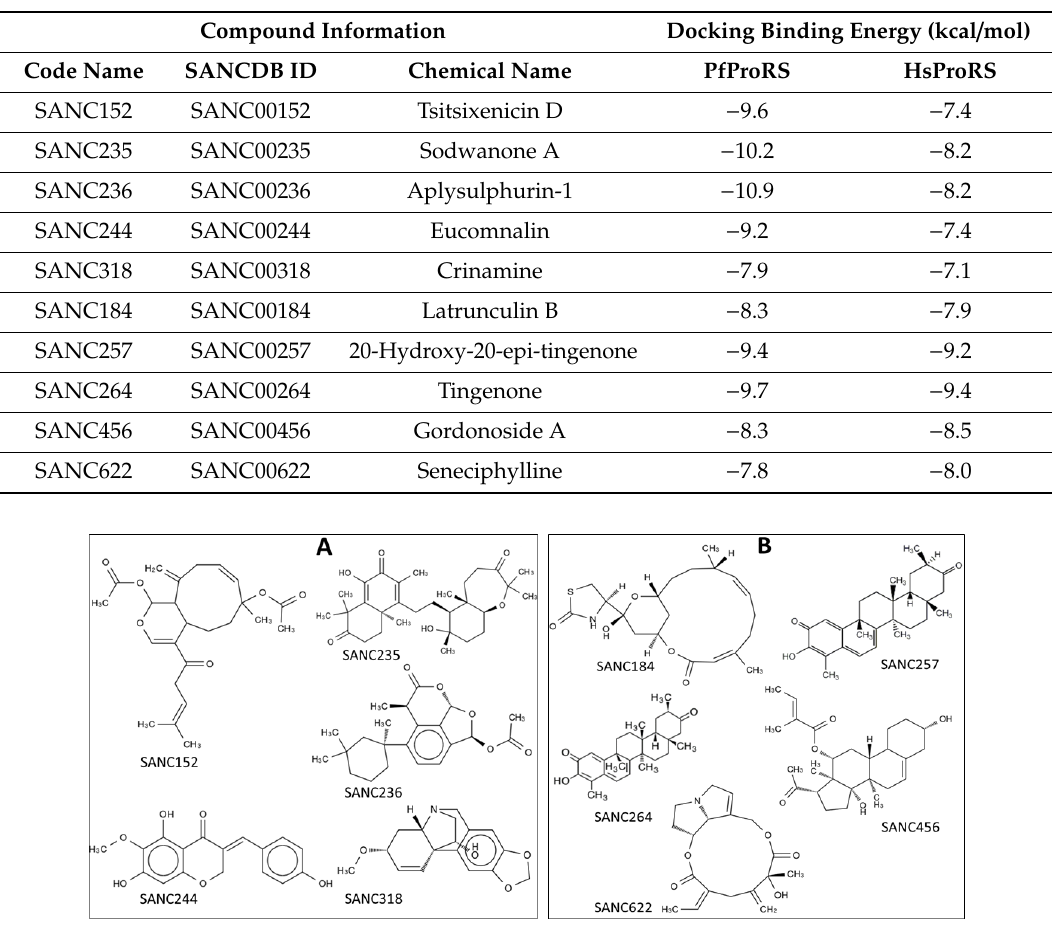
Table 1. South African natural compound hits and docking binding energy information.